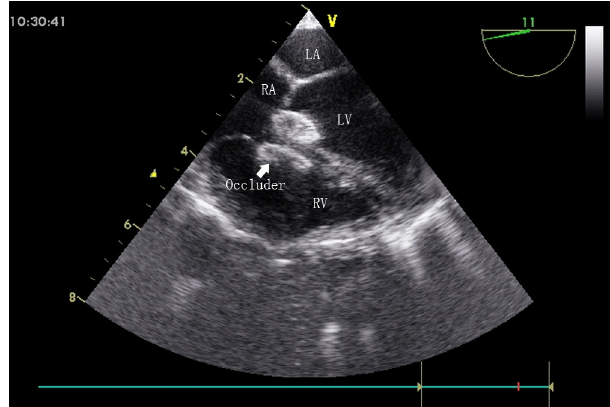
Fig. 3 – Final image showing after both discs (arrow) were deployed in group A